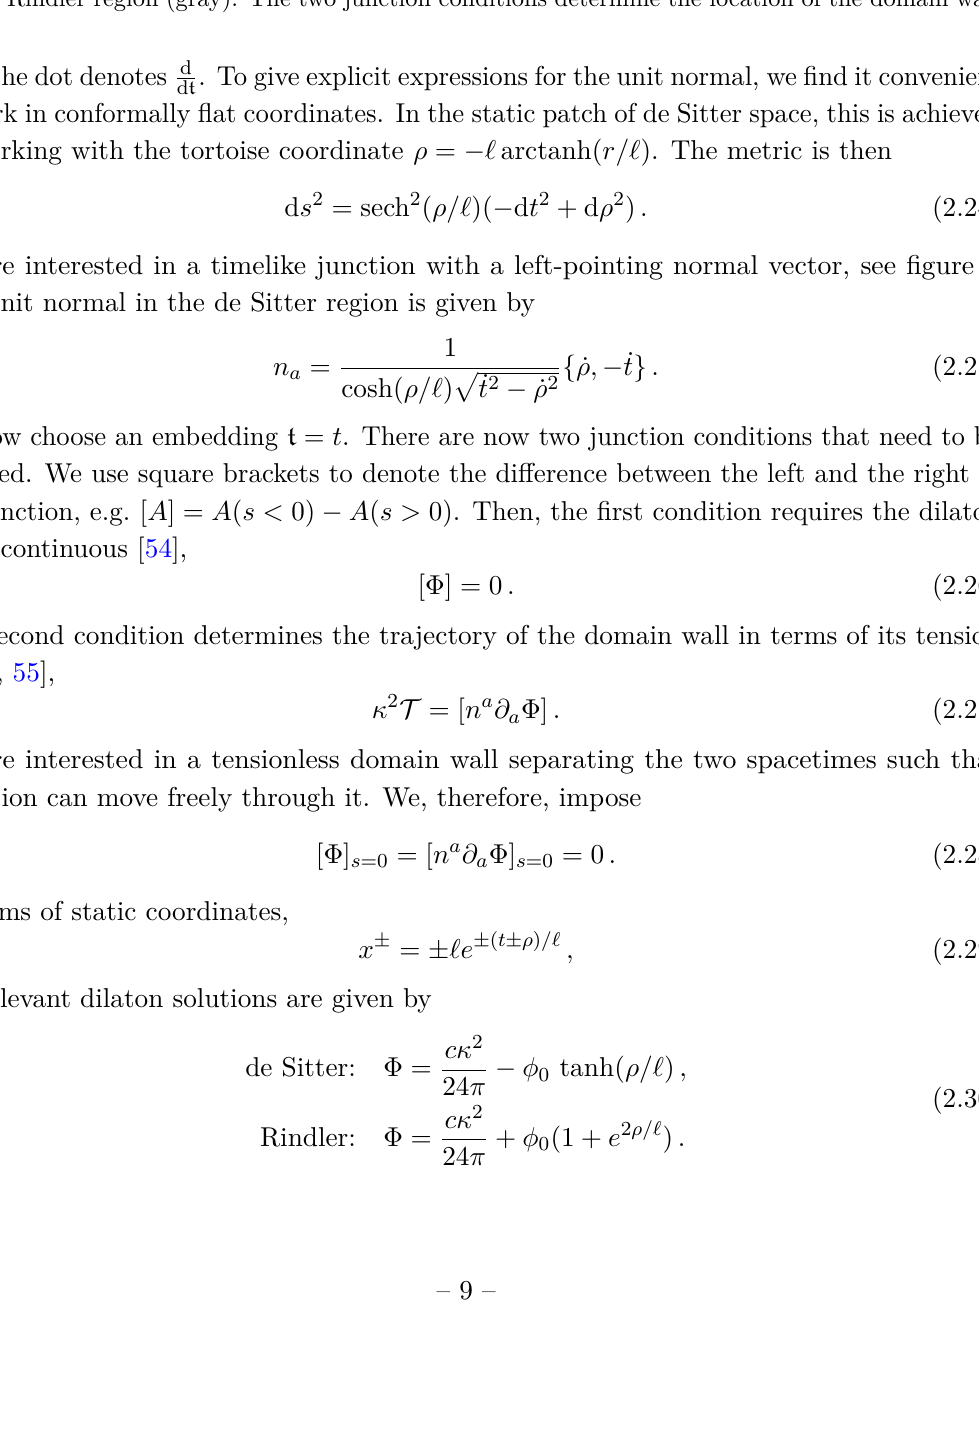
Figure 3 . Domain wall with normal vector n a separating part of a de Sitter static patch (white) from a Rindler region (gray). The two junction conditions determine the location of the domain